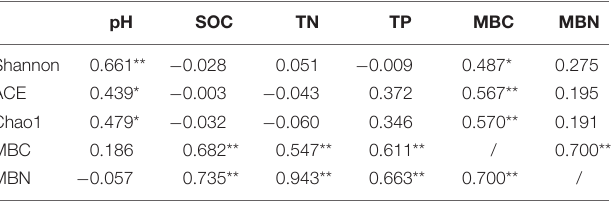
TABLE 2 | Correlation between alpha diversity of soil bacterial communities and microbial biomass and soil